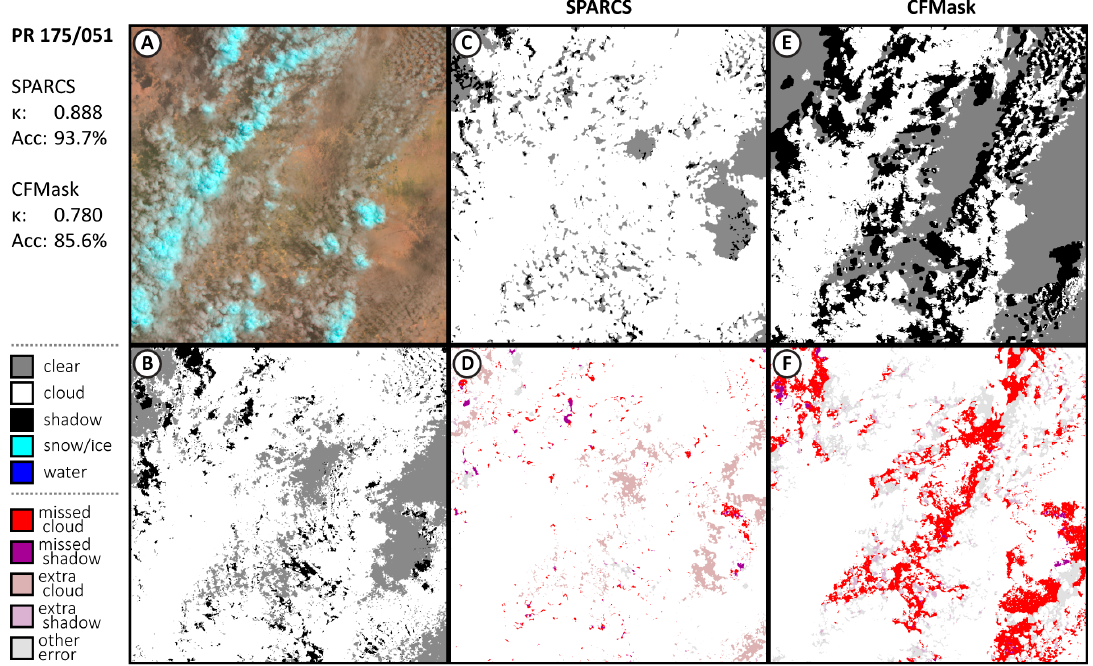
Figure A8. Results for Biome test image from PR 175/051, with false color image used during interpretation (A), the manually labeled interpretation (B), generated masks from SPARCS (C) and CFMask (E), and respective spatial distribution of errors (D, F).